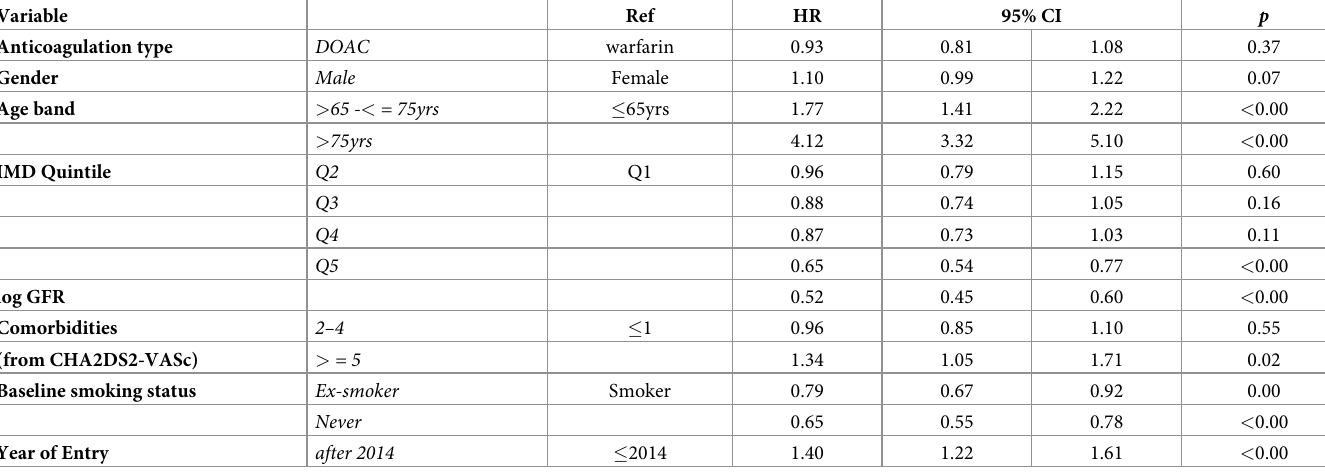
Table 4. Multivariate analysis of the cause-specific hazard ratio (CSHR) for all-cause mortality, interpreted as time-averaged effects. Variable